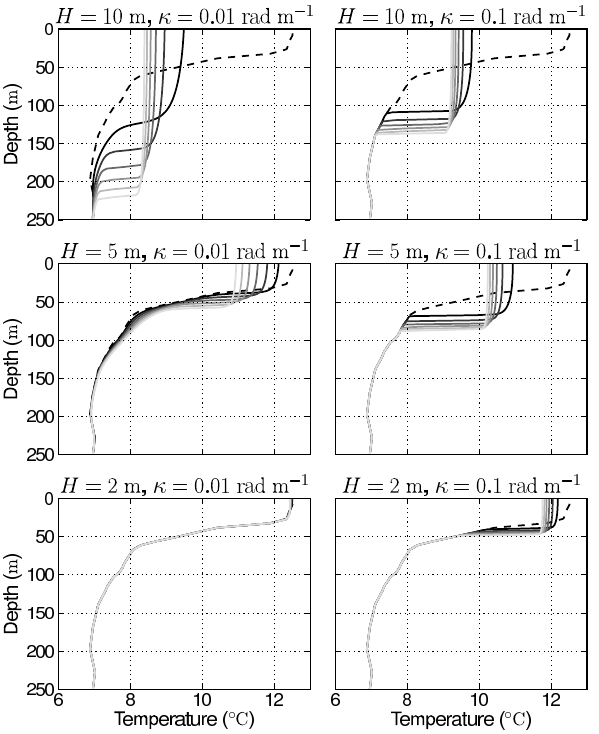
Fig. 2. As for Fig. 1 but for a wider range of wave heights and wave numbers.